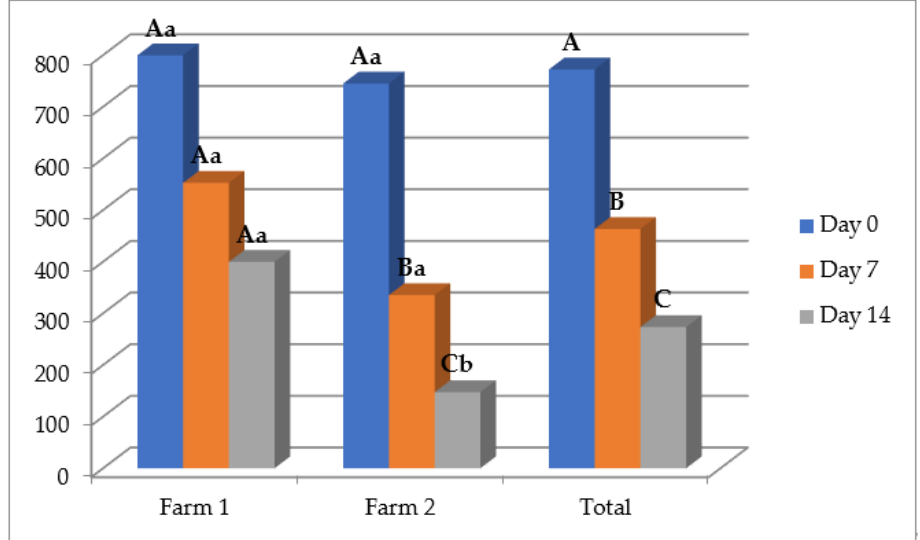
Figure 2. Mean number of eggs per gram at different time points after the treatment in a group of animals treated with the Origanum vulgare essential oil; uppercase compares means between different time points on the same farms, and lowercase between different farms on the same time points. Different letters indicate significant differences ( p < 0.05).